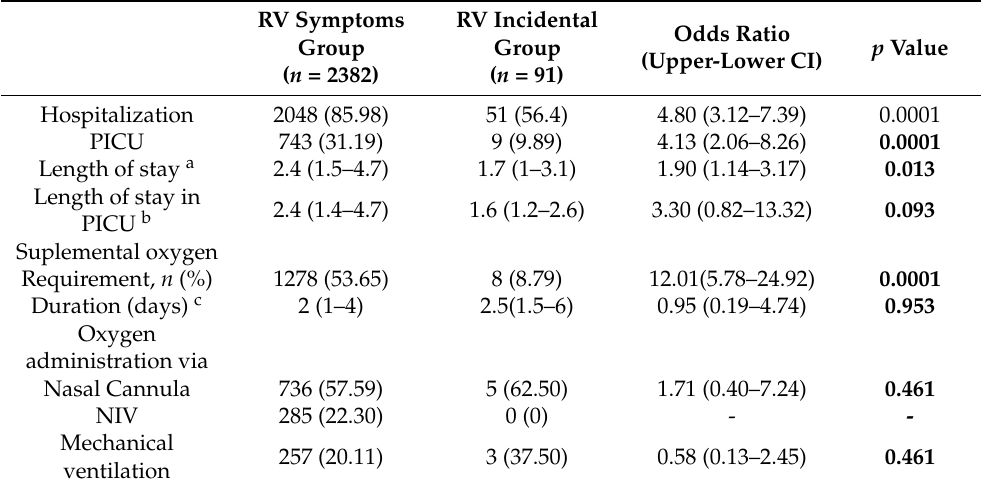
Table 5. Univariate associations of disease severity parameters according to clinical presentation.